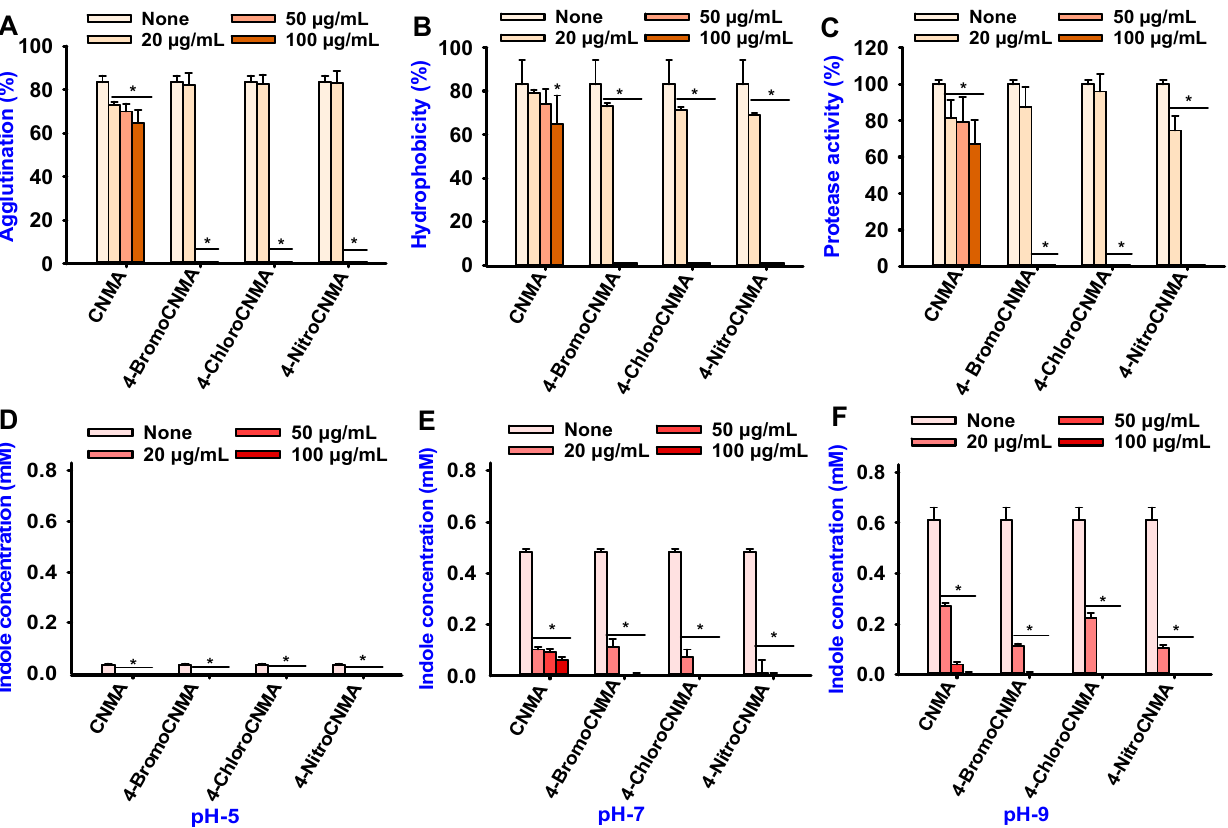
Figure 4. Effect of CNMAs on the virulence factors. Fimbriae mediated yeast agglutination ( A ), hydrophobicity ( B ), and protease activity ( C ) of V. parahaemolyticus . Indole production in V. parahaemolyticus at pH 5 ( D ), pH 7 ( E ), and pH 9 ( F ). The error bars and asterisks (*) represent standard deviations and significant differences ( p < 0.05), respectively, vs. the non-treated controls.